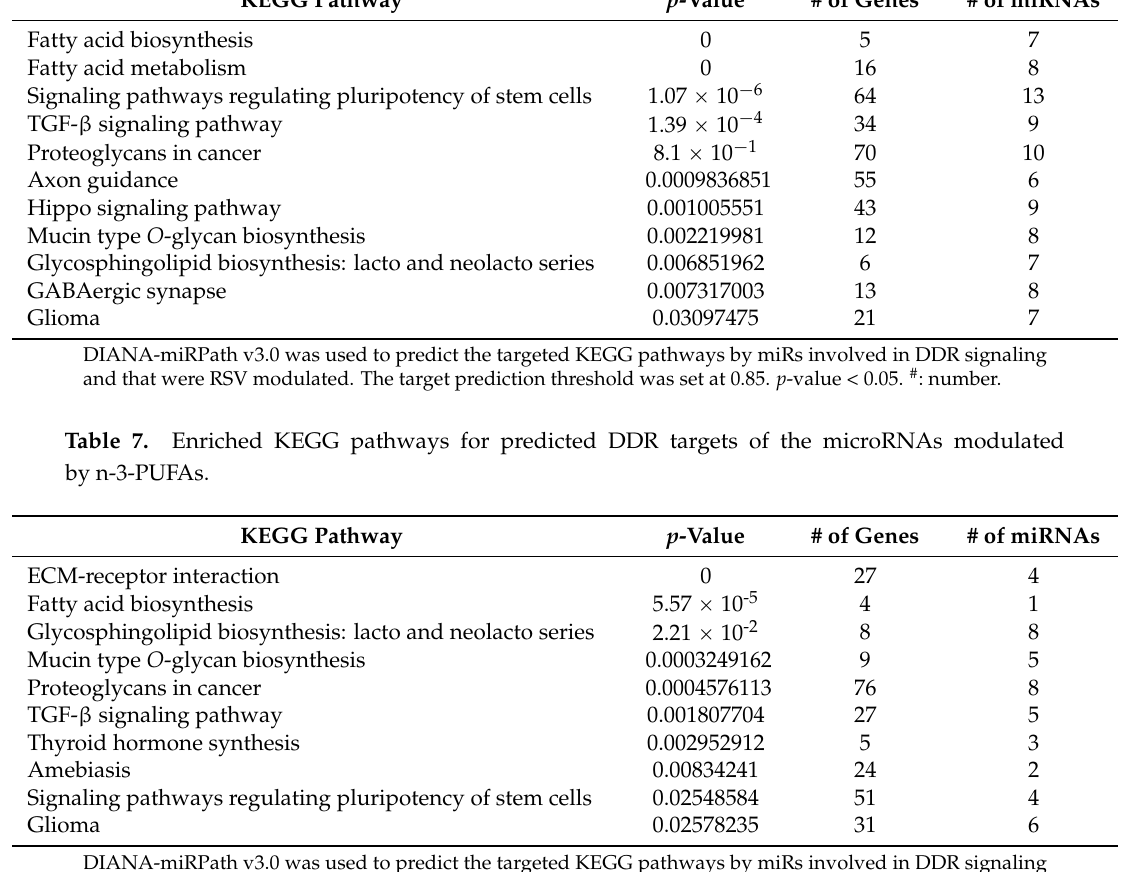
Table 6. Enriched KEGG pathways for predicted targets of the DDR microRNAs modulated by RSV. KEGG Pathway